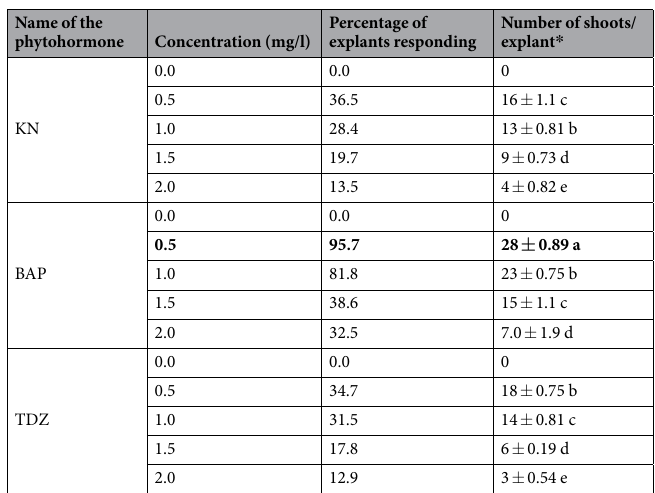
Table 1. Effect of phytohormone on multiple shoot induction from shoot apex explants in foxtail millet genotype Maxima. Response was noted after 3 weeks of incubation at 25 ± 2 °C in light. * Values are expressed as mean ± SD of 3 replications and 3 repeats. Values followed by the same letter are not significantly different based on a t-test (P <